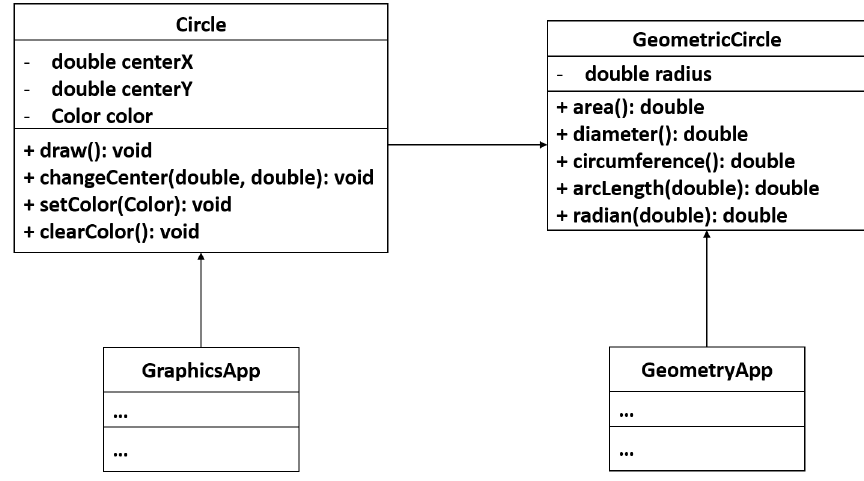
Figure 2. The Class Circle in Figure 1 is split into two classes: Circle and GeometricCircle